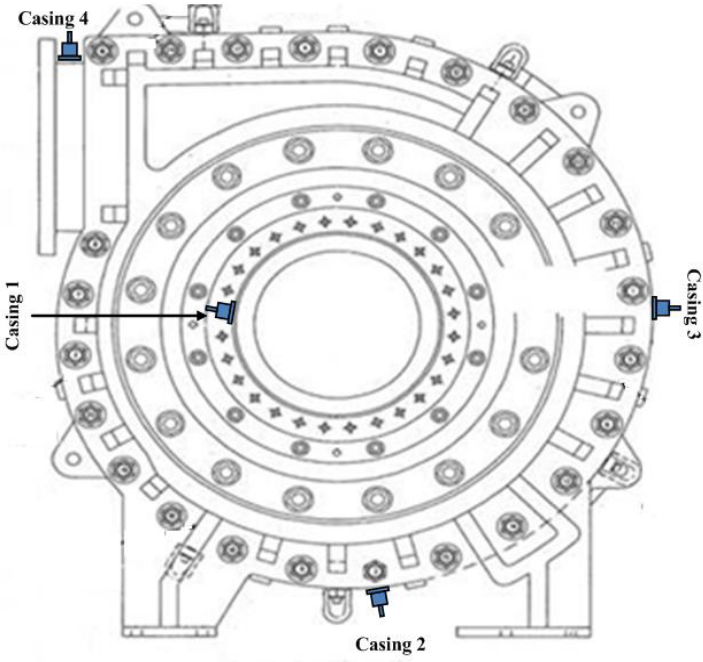
Figure 2. The measurement locations of the four accelerometers mounted on a slurry pump (the four accelerometers named as casing 1, 2, 3 and 4)